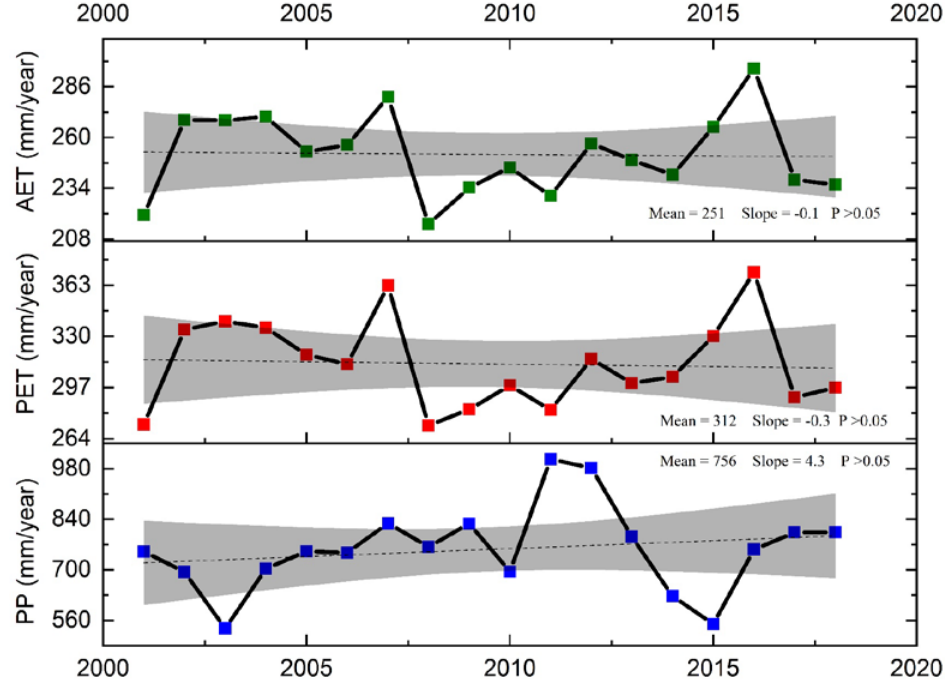
Figure 3. Time series of the global annual mean for AET, PET, and PP.